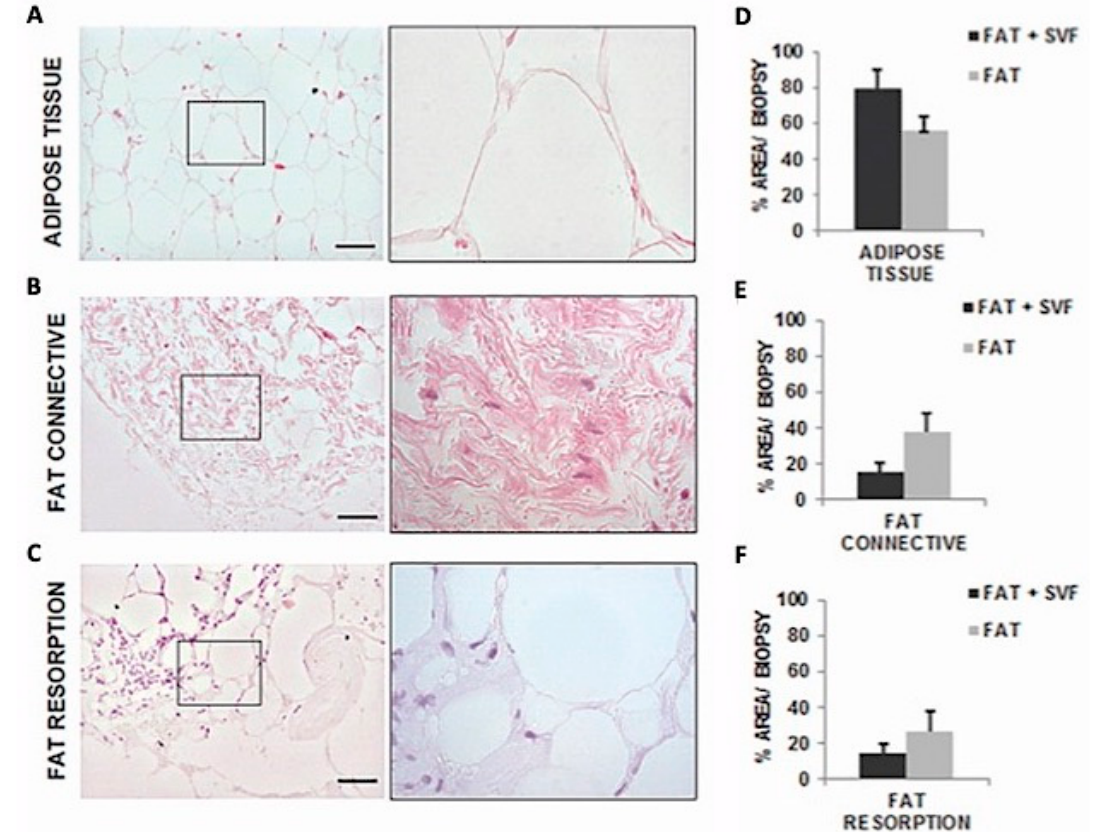
Figure 6. Images of Hematoxylin and Eosin stained sections (100 × magnification and inset 400 × ) with tissue distribution for the three identified histological features within the biopsies sections. In both groups (SG and CG1) Adipose Tissue (AT) ( A ) were characterized by round shaped adipocyte without any abnormality. Both groups presented connective tissue (CT) ( B ), characterized by fibroblastoid cells surrounded by oriented collagen fibers. Fat reabsorption area was an anomalous AT composed by inflammatory cells infiltrating the lobules of adipocytes and associated by small / medium size cysts delimited by polymorphonucleated cells ( C ). On average, these adipocytes had higher diameter in size versus the normal adipocytic cells. ( D – F ) showed the comparison of score system results between the two groups in the attempt to investigate the contribution of SVF in the maintenance of AT and CT-reabsorption reduction.